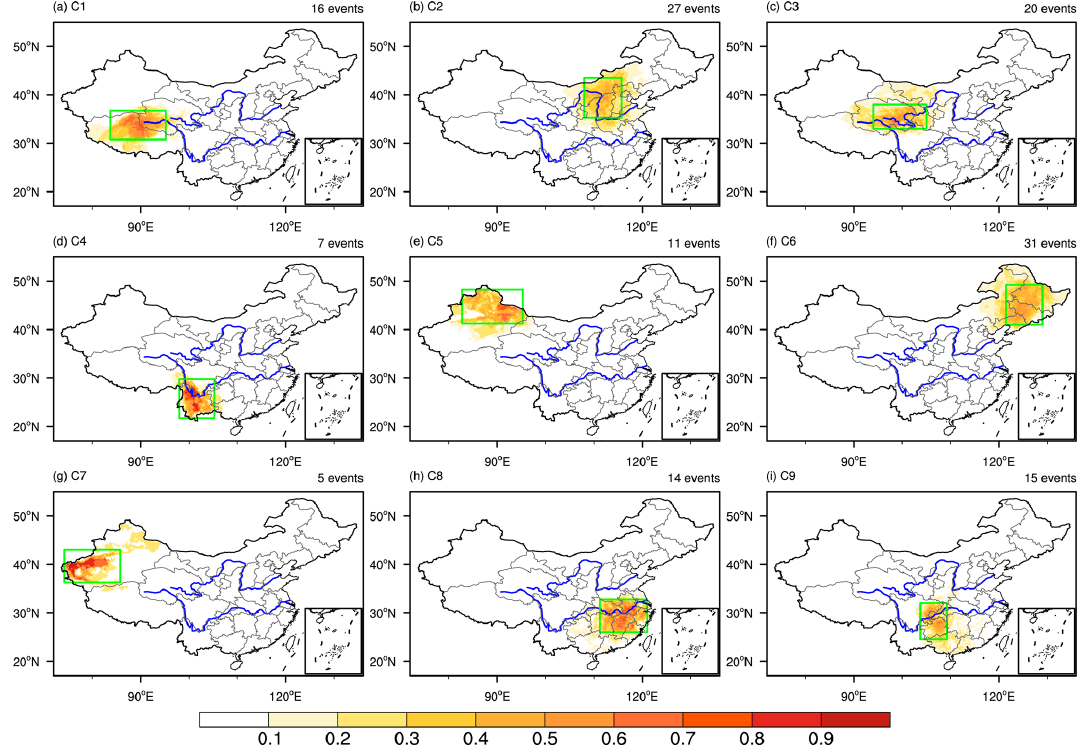
Figure 9. The spatial pattern of nine SLDDH event clusters in the study area. For each cluster, shading represents the percentage of SLDDH days affecting each grid point. The number of events in each cluster is listed in the upper-right corner of each panel.